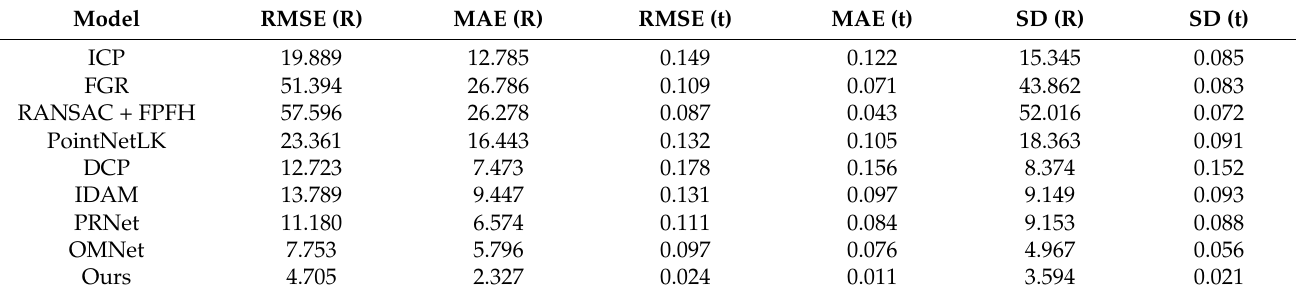
Table 1. Results for testing on point clouds of unseen shapes in